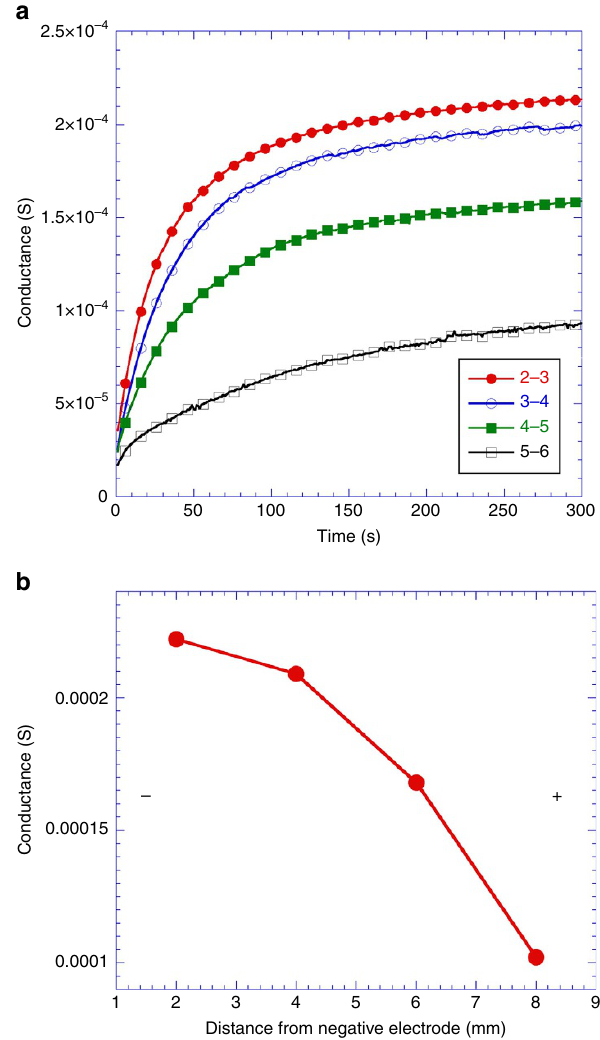
Figure 6 | Evidence of a conduction gradient. ( a ) Time dependence of conductance measured between adjacent pairs of voltage pick-off electrodes (denoted in the legend), with a constant current of 5E-5 amps flowing between electrodes 1 and 7 (see Fig. 1 for electrode configuration). Measurements were taken at 370 (cid:2) C, with the sample equilibrated at p O 2 ¼ 1.5 torr. ( b ) Conductance as a function of position on the sample, at and shows a gradient across the sample.